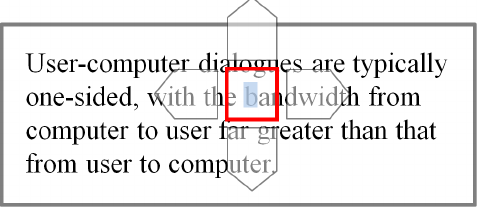
Fig. 8 The button for specifying the cursor